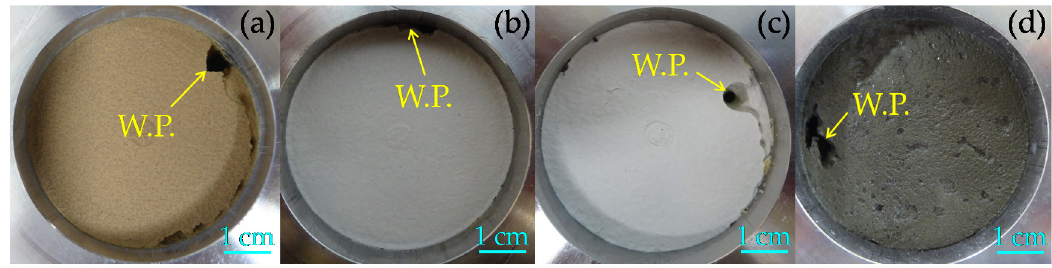
Figure 8. Observation of water path (W.P.) in the samples (downstream side) that significantly affect the hydraulic conductivity. ( a ) 1.0 nm halloysite, ( b ) pyrophyllite ( c ) talc, and ( d ) chlorite samples.